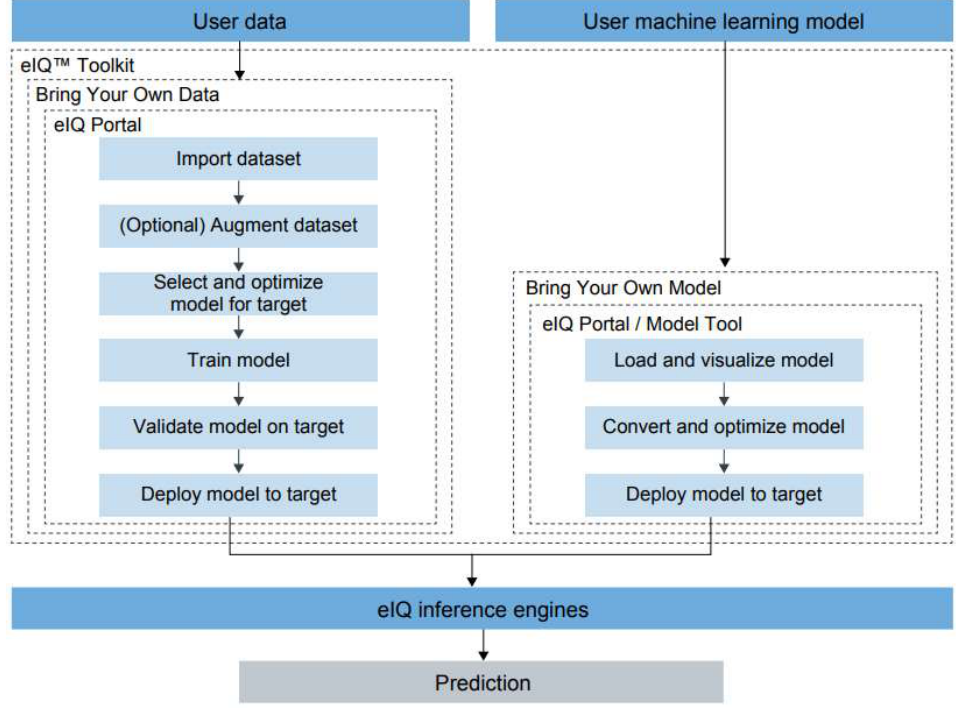
Figure 4. NXP Image Signal Processing Software (optimized by OpenCL 1.2 and OpenVX 1.1) [75].